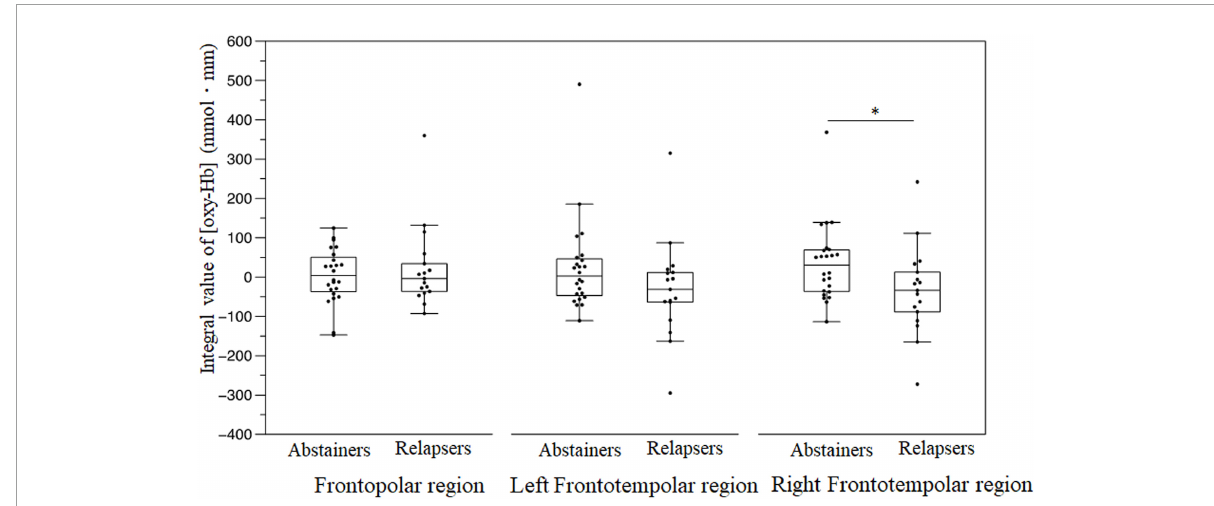
FIGURE5 Brain activation displayed as the integral value of (oxy–Hb) in the frontopolar, left frontotemporal, and right frontotemporal regions during the emotional go/no-go task. ∗ P < 0.05.